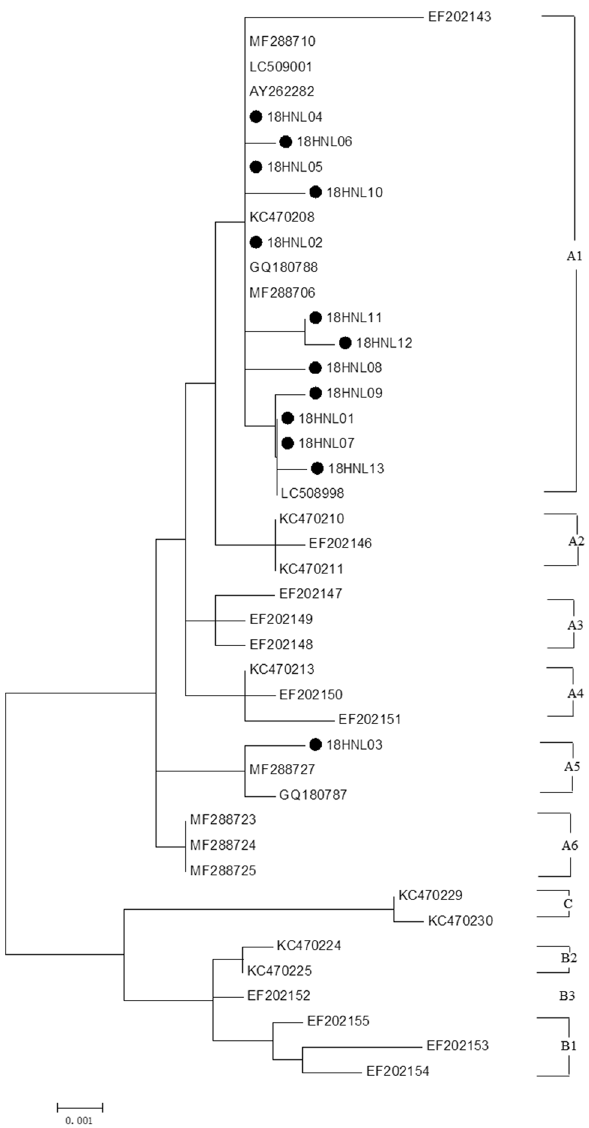
Figure 2. Phylogenetic tree generated using nucleotide sequences of the HPV18 L1 gene. Study sequences are labeled in dots, others without dots are reference strain, including: A1 (AY262282, EF202143, MF288710, LC509001, KC470208, GQ180788, MF288706, LC508998), A2 (EF202146, KC470210, KC470211), A3 (EF202147, EF202148, EF202149), A4 (EF202150, EF202151, KC470213), A5 (GQ180787, MF288727), A6 (MF288723, MF288724, MF288725), B1 (EF202153, EF202154, EF202155), B2 (KC470224, KC470225), B3 (EF202152) and C (KC470229, KC470230). Phylogenetic trees were constructed by the Maximum Likelihood by MEGA 6.0 package. Only bootstrap values above 70% are displayed in the